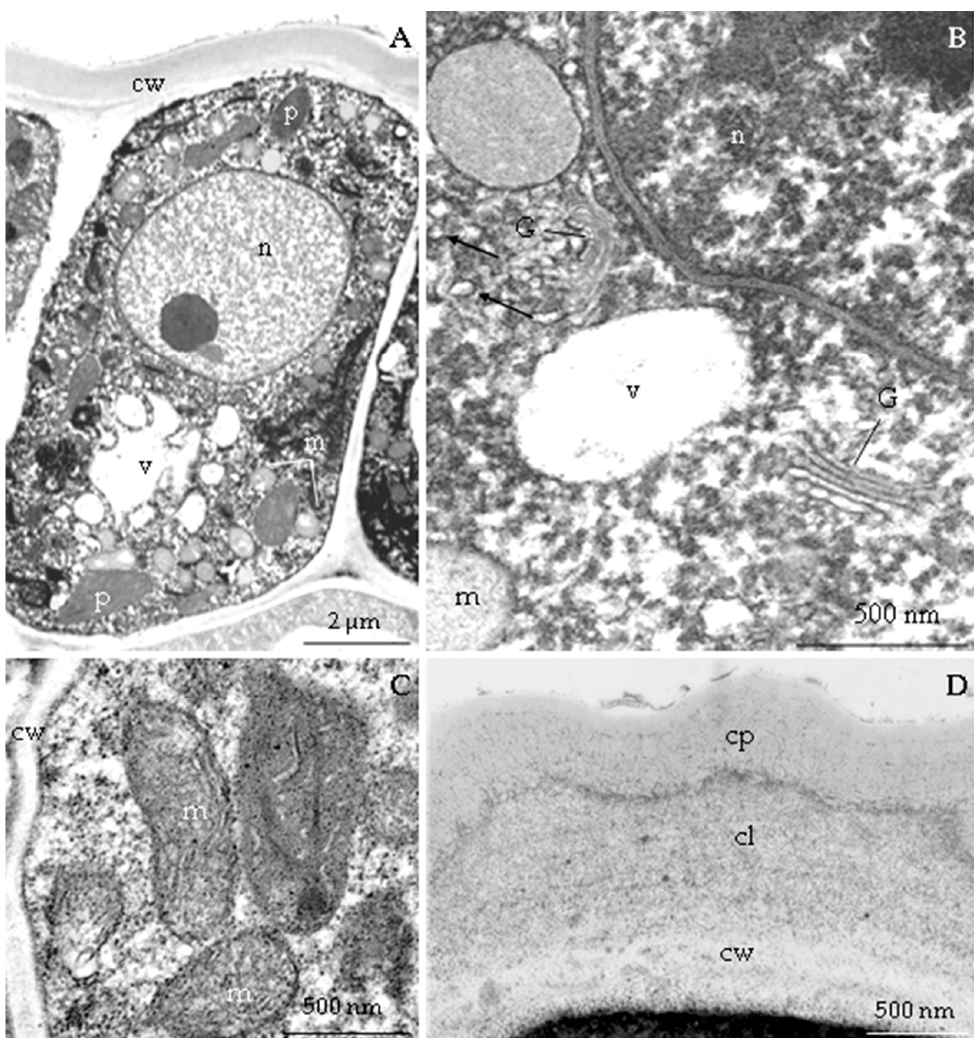
Figure 12. ( A – D ). Fragments of nectary epidermis ( A , B ) and parenchyma ( C , D ) cells in R. idaeus ‘Glen Ample’ in the full secretion phase. ( A ): cell wall (cw), slight cell vacuolization (v), pleomorphic plastids (p), mitochondria (m), nucleus (n). ( B ): nucleus (n), Golgi apparatus (G) located near the nuclear membrane, transport vesicles (arrow), vacuole (v). ( C ): mitochondria with distinct cristae (m) near the cell wall (cw). ( D ): epidermis outer cell wall (cw) with a visible cuticle proper (cp) and cuticle layer (cl). Table 5. Thickness of the cell wall of the nectary epidermis in R. idaeus cultivars ( µ m). R. idaeus